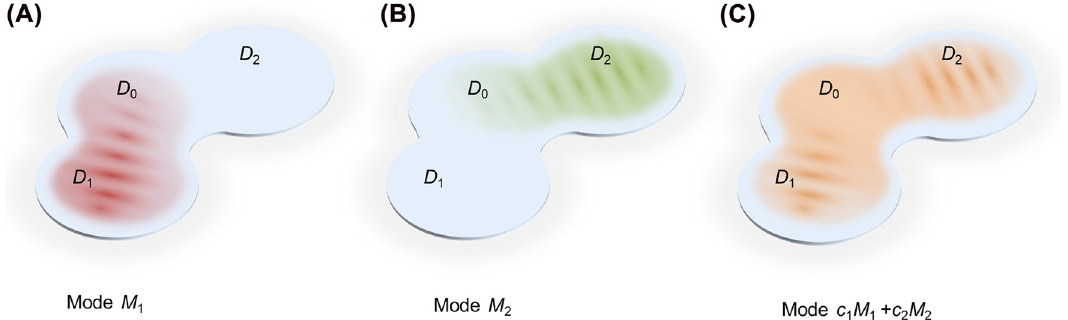
Figure 1: The concept of a hybrid-wave resonator. A resonator structure that supports two degenerate standing-wave modes such that (A) ∪ D ∪ D mode M resides in domain D , and (B) mode M resides in domain D . (C) It is possible that a proper linear superposition between 1 0 1 2 0 2 M 1 and M 2 can result in new modes that preserve the standing-wave character in domains D 1 , 2 while at the same time form a traveling wave in domain D . In the figure, standing and traveling waves are schematically represented by interference fringes and uniform field 0 distributions